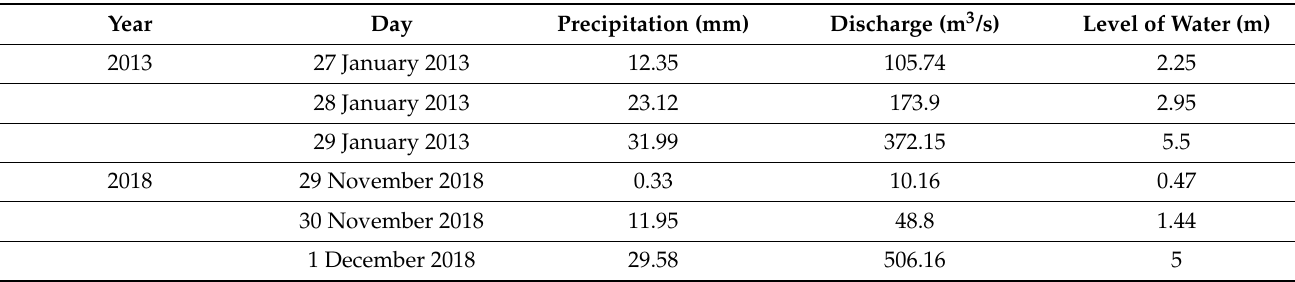
Table 10. Hydrological characteristics of the river during the study period.